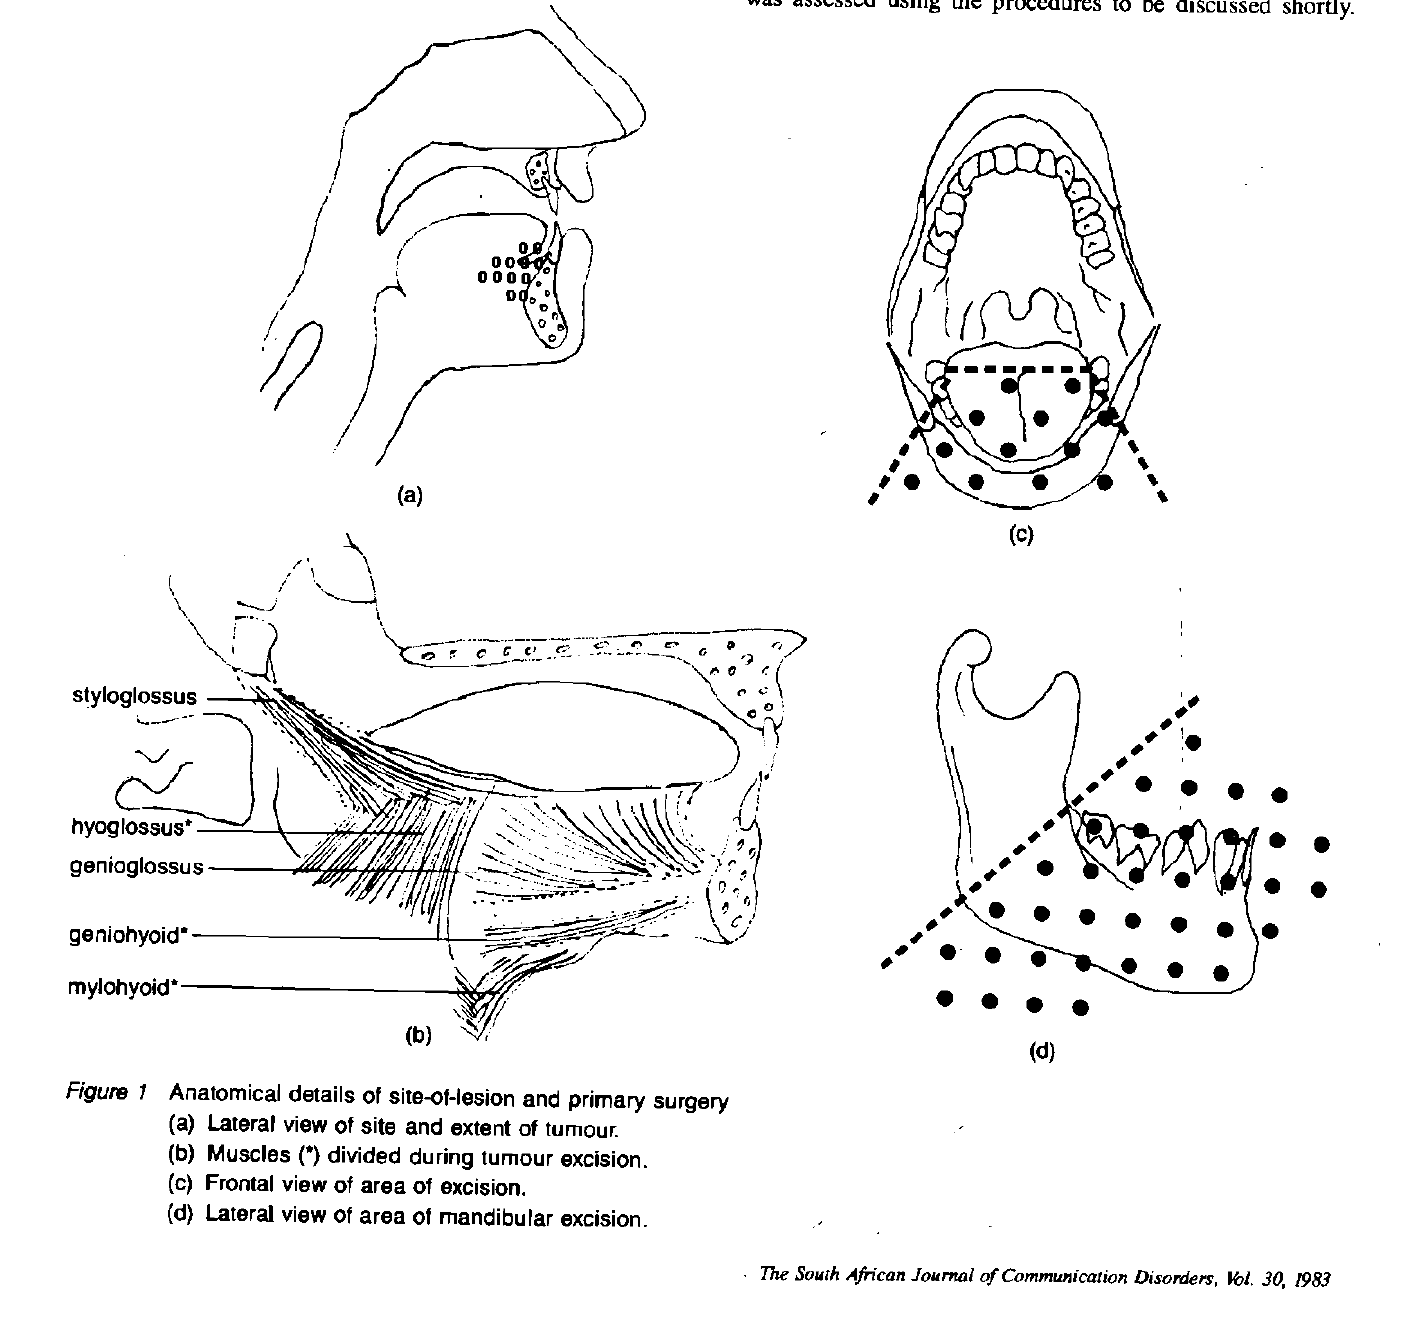
Figure 1 Anatomical details of site-of-lesion and primary surgery (a) Lateral view of site and extent of tumour. (b) Muscles (*) divided during tumour excision. (c) Frontal view of area of excision. (d) Lateral view of area of mandibular